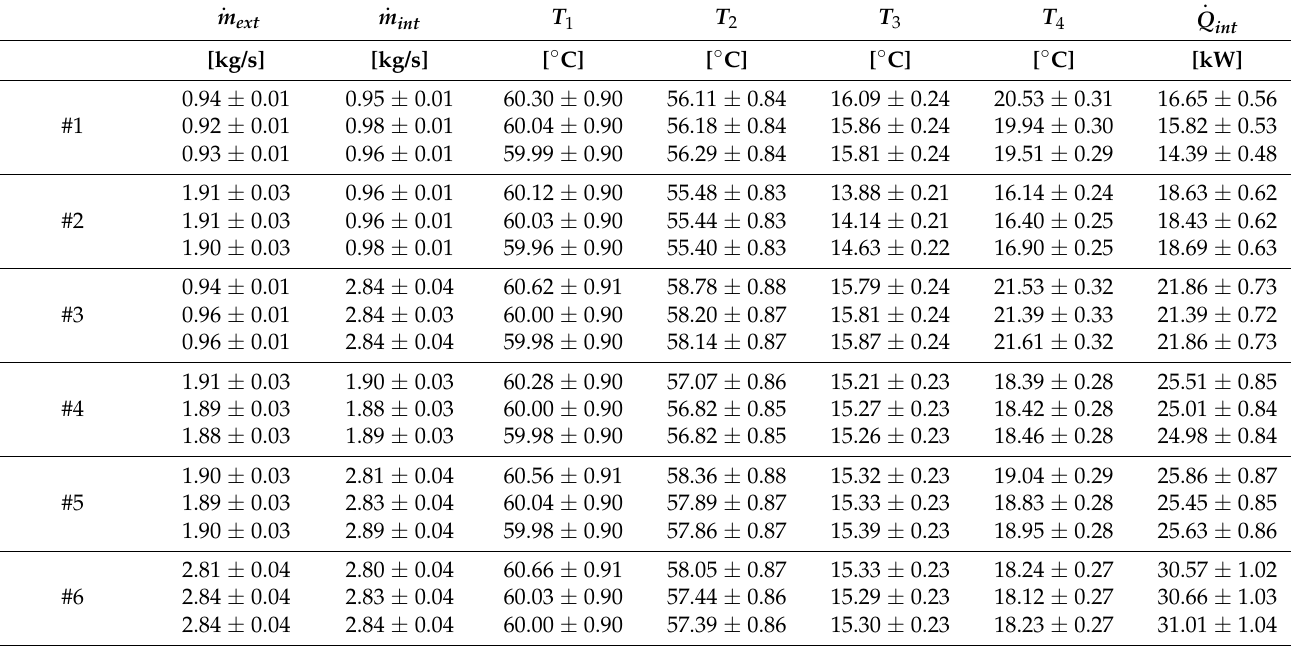
Table 3. Experimental measurement data of tube heat